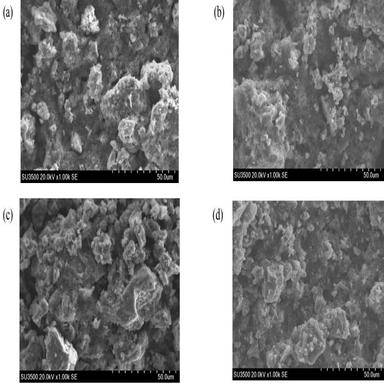
SEM image from electrode sheets of LiFeSixP1-xO4/C with (a) x = 0;(b) x = 0.05;(c) x =0.10; and (d) x = 0.15